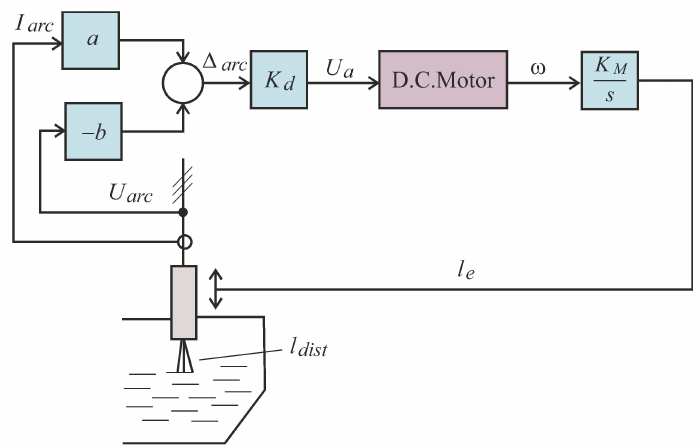
Figure 10. Structural-functional diagram of the electrode movement